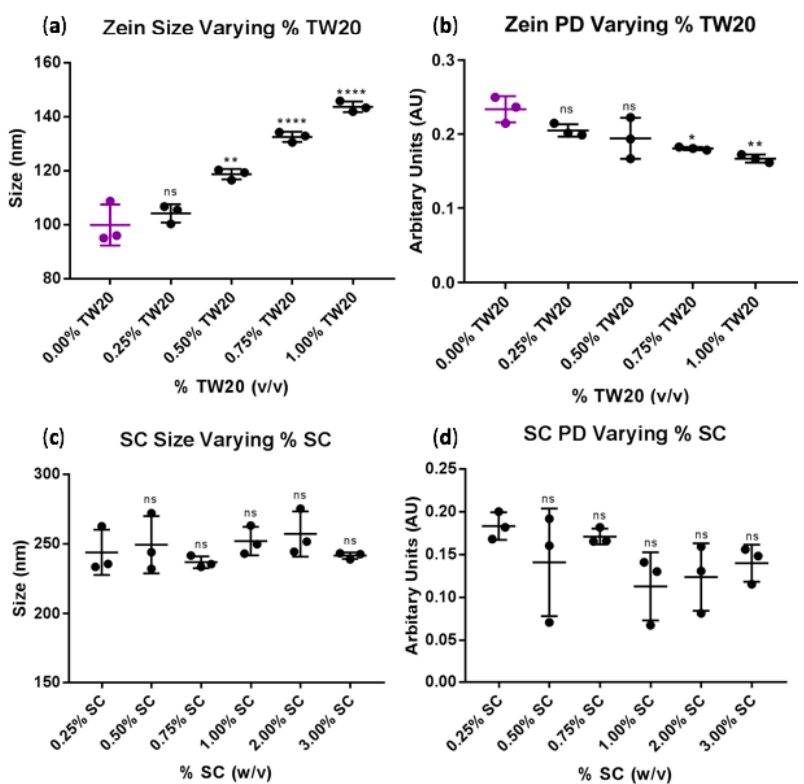
Figure A1. ( a ) The diameter of Zein nanoparticles (NPs ’ ) varying% Tween 20 (TW20); ( b ) the polydispersity (PD) of Zein NPs ’ varying% TW20; ( c ) the diameter of sodium caseinate (SC) varying% SC when produced using the standard microfluidics conditions of Zein; ( d ) the PD of SC varying% SC when produced using the standard microfluidics conditions of Zein.